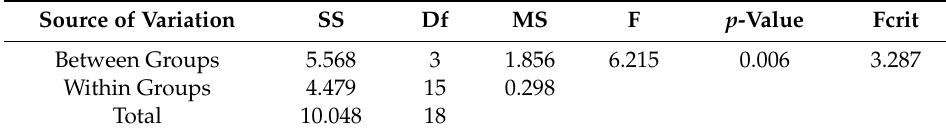
Table 2. Analysis of variance (ANOVA) of tensile strength and b. post hoc analysis.